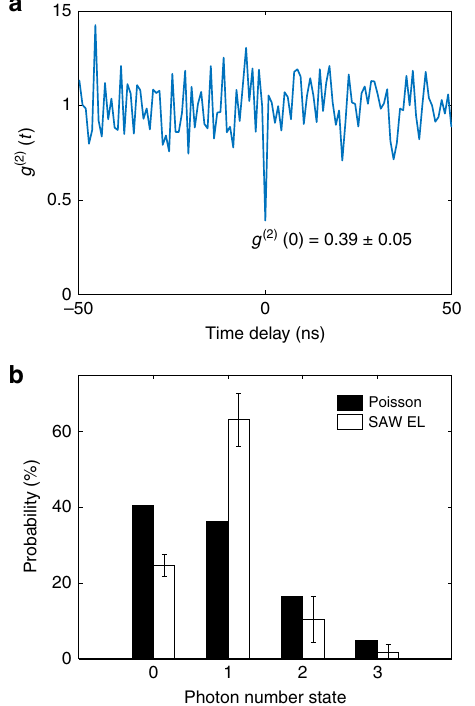
Fig. 4 SAW-driven single-photon emission in the single-electron regime. a The second-order correlation function g (2) ( Δ t ), which is obtained after fi tting the autocorrelation histogram to G 0 ð Δ t Þ . g (2) (0) = 0.39 ± 0.05 < 0.5 shows that the SAW-driven lateral n-i-p junction produces single- photon emission from the single-electron transport. b Estimated probability distribution of photon-number states n j i in the SAW-driven EL, compared with the probability distribution in a Poissonian light source with N avg = 0.89. See Supplementary Note 5 for error